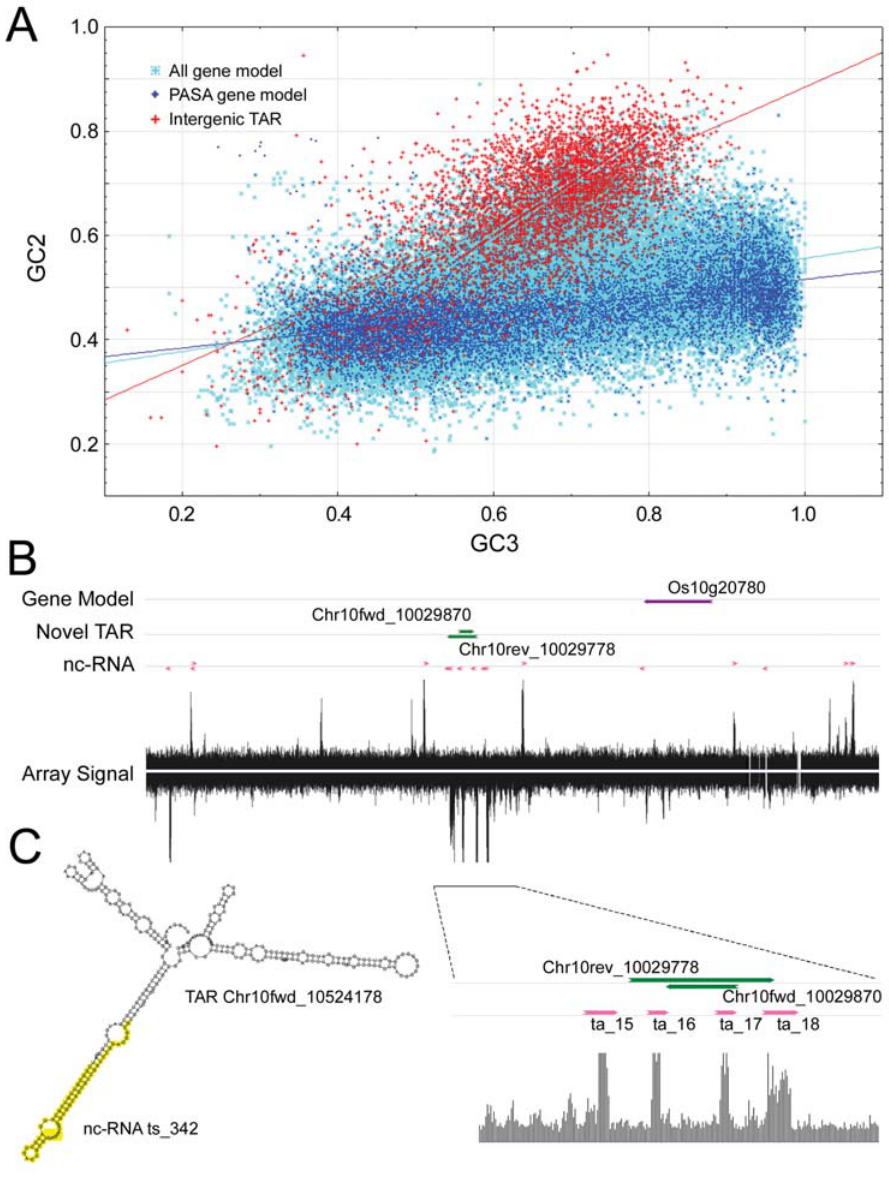
Figure 6. Analysis of non-coding intergenic TARs. (A) Scatterplot of GC2 versus GC3 in all gene models (n=46,976), FL-cDNA-supported PASA gene models (n=11,494), and intergenic TARs (n=5256). The intergenic TARs were distal ( . 1Kb) to a gene model excluding those with a hit in the ProSite database. (B) Overlapping TARs with putative non-coding transcripts. A 5-Kb region represented by the high-resolution tiling array is shown. The interrogating probes are aligned to the chromosomal coordinates, with the fluorescence intensity value depicted as a vertical line. Gene models, no- exonic TARs and putative non-coding transcripts are depicted as horizontal arrows, which point to the direction of transcription. A portion of the region containing four non-coding transcripts and a pair of TARs is enlarged and shown at the bottom. (C) Predicted secondary structure of the TAR Chr10fwd_10524178. The sequence corresponding to the putative nc-RNA ts_342 is highlighted.